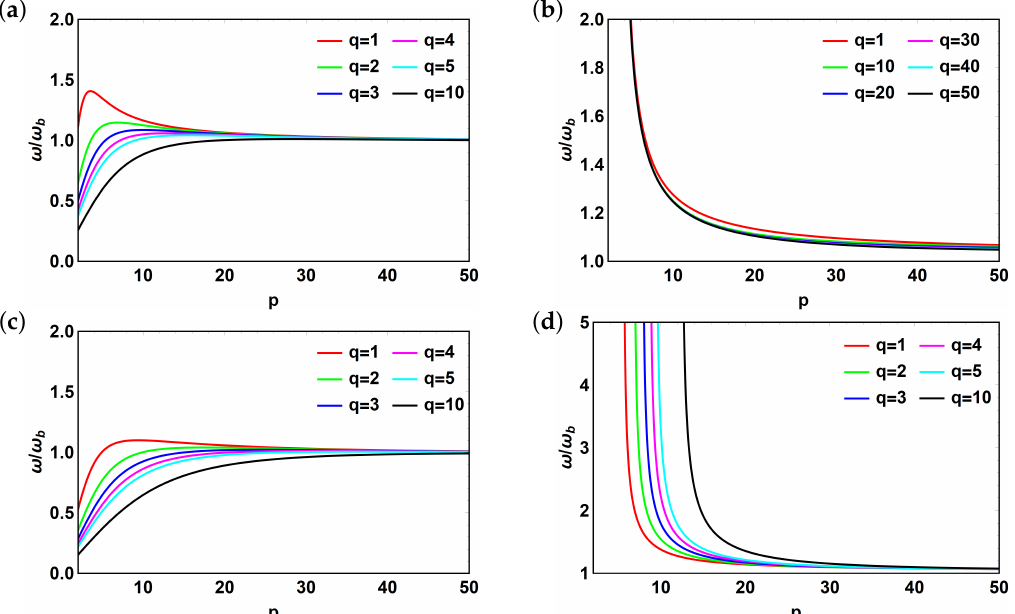
Figure 8. Normalized frequency as a function of p (distance between bubble centers) for metascreen ( a ) w/2 interfaces and w/o reflector, “positive” branch, kh (cid:28) 1; ( b ) w/2 interfaces and w/o reflector, “negative” branch, kh (cid:28) 1; ( c ) w/2 interfaces and w/reflector ( r 0 = 0.5), “positive” branch, kh (cid:28) 1; ( d ) w/2 interfaces and w/reflector ( r 0 = 0.5), “negative” branch, kh (cid:28)